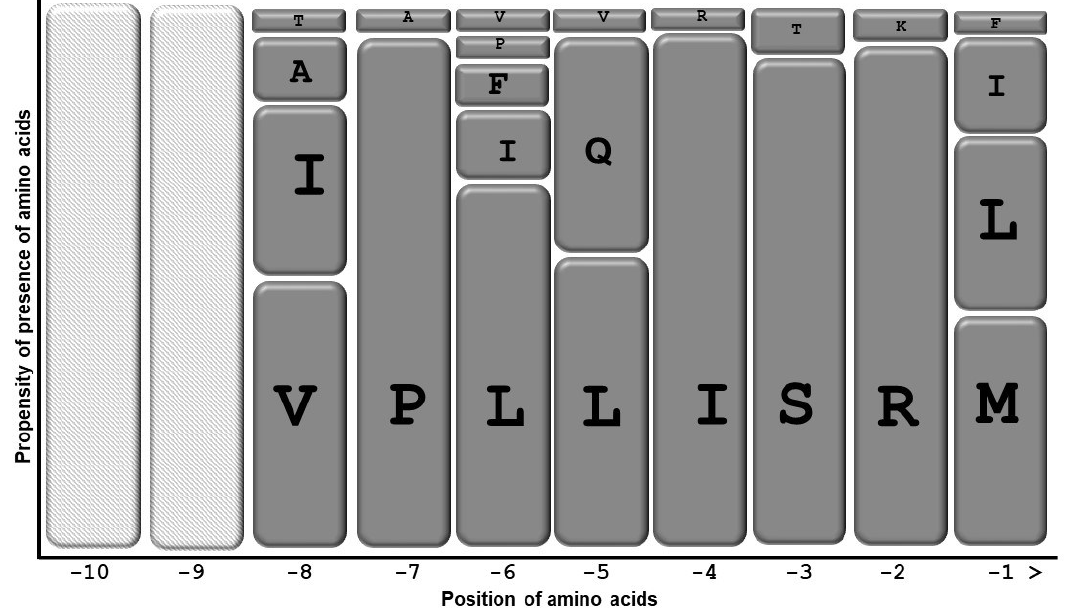
Figure 4. Graphical representation of PTS1 domain present in the PAO of various plants. A total of 153 PAO enzyme sequences were obtained from NCBI. The sequences were aligned using CLUSTAL W 2.1 (Supplementary Figure S1). From the multiple sequence alignments, the consensus amino acids were derived. The y -axis shows the propensity of the presence of specific amino acids at specific positions, while the x -axis represents the position of amino acids at the C-terminus of the respective protein. “>” denotes the end of the polypeptide chain. Each amino acid is represented by one rectangular box. The higher the size of the rectangle, the higher the propensity of the amino acid to remain present at that specific position. The empty rectangle represents high variability.